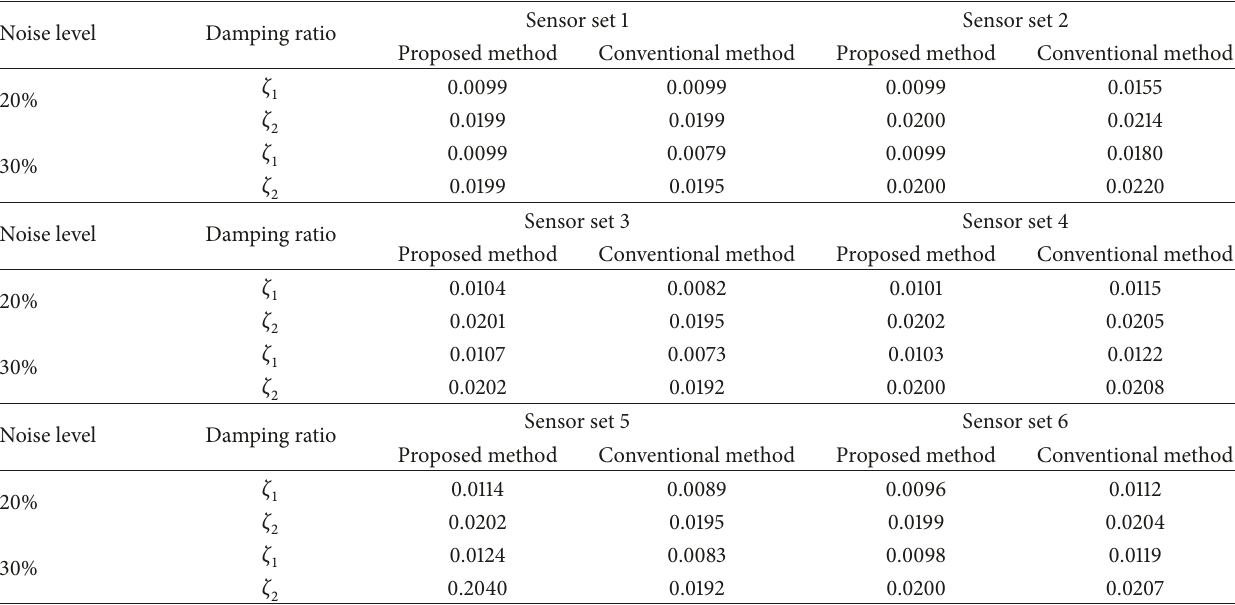
Table 8: Identification results with 20% and 30% measurement noise.